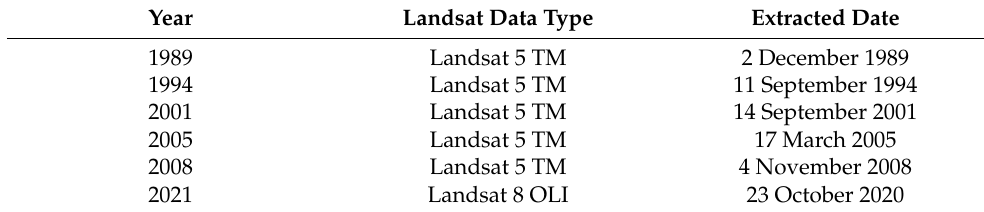
Table 2. Landsat data used for the present